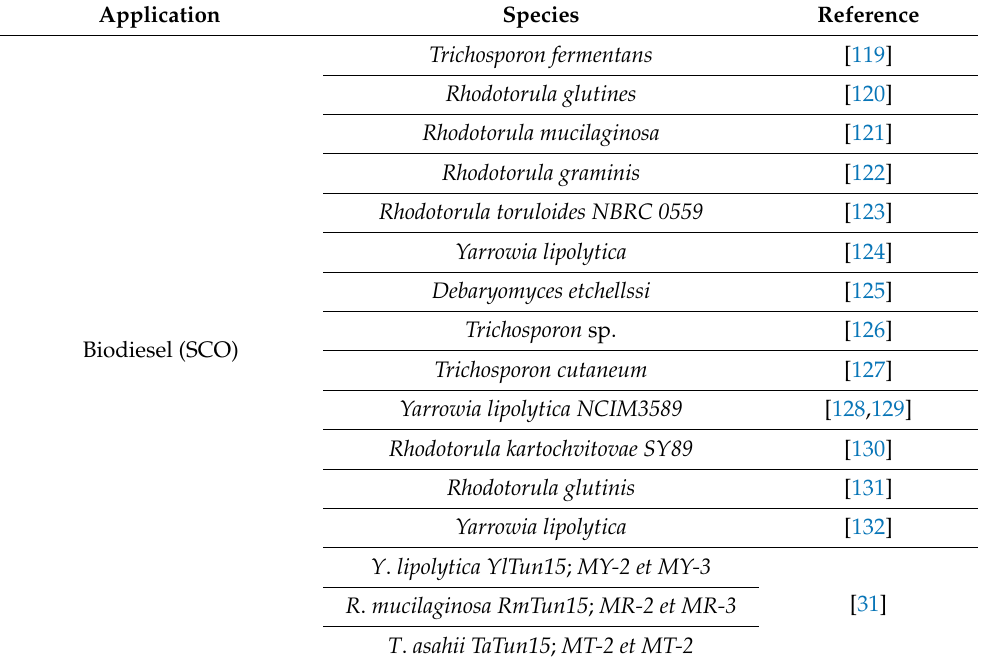
Figure 2. Effect of 1 (TaTun15), 2 (RmTun15), 3 (YlTun15), 4 (DhTun2015) and 5 (CtTun15) samples on HEK293 cells. Effect of different 1, 2, 3, 4, and 5 samples concentration on HEK293 cells survival. All data are expressed as mean of at least three independent experiments ( A ). Analysis of HEK293 cells morphology in untreated ( a ) and treated HEK293 cells ( b ) with the marine yeast 1 (TaTun15), 2 (RmTun15), 3 (YlTun15), 4 (DhTun2015), and 5 (CtTun15) after 24 h of incubation ( B ). Table 6. Application field of marine